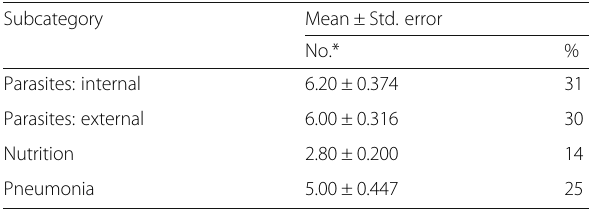
Table 8 Importance of goat diseases in rural areas of the Nile Delta in